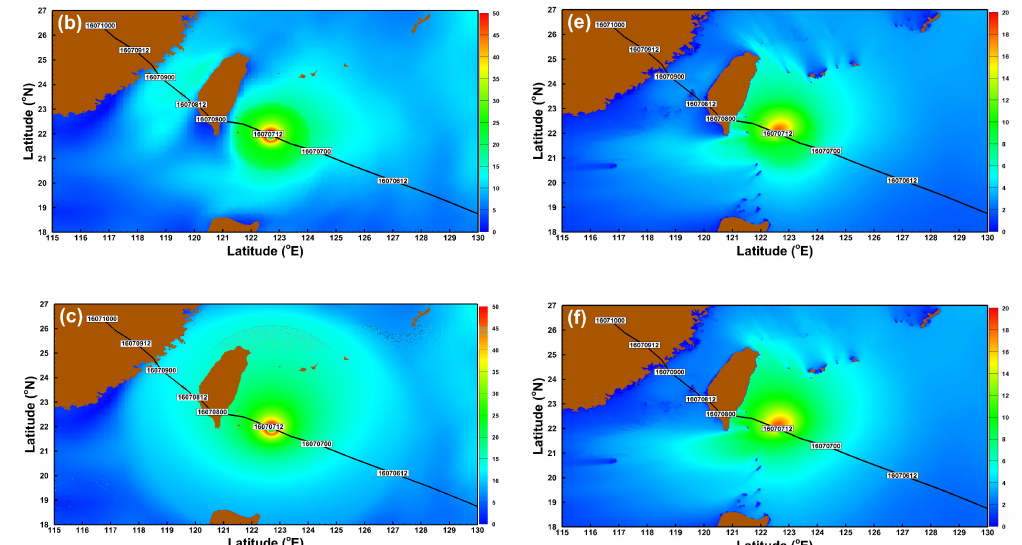
Figure 10. Instantaneous wind field distribution from the ( a ) hourly ERA5, ( b ) ERA5_1hr_H1, and ( c ) ERA5_1hr_H2 and their corresponding SWHs ( d – f ) for Super Typhoon Nepartak at 11:00 on 12 July in 2016.